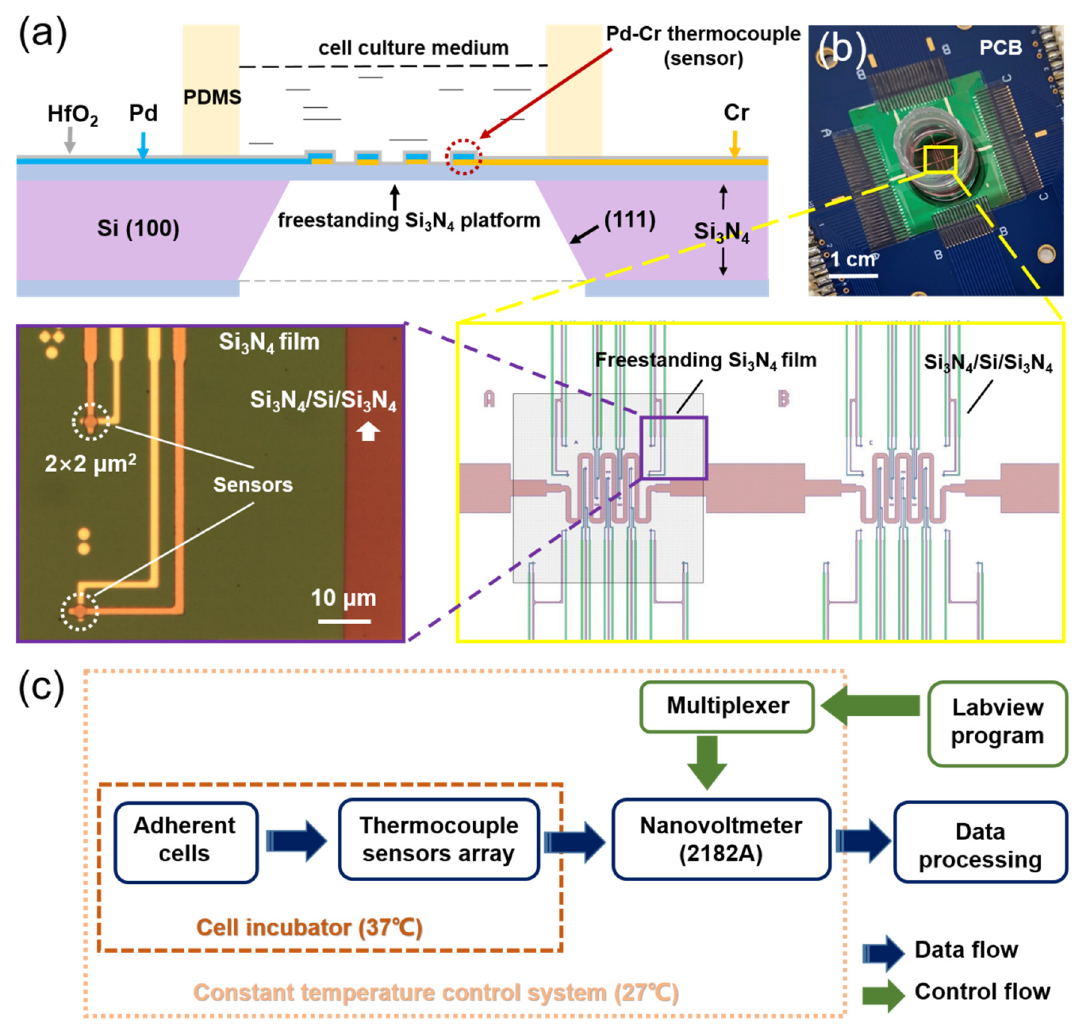
Figure 1. Schematic illustration of the new biochip and measurement system. ( a ) Schematic diagram of a cross-section of the functional area on the chip. The cream-colored bars labeled PDMS represent a cross-section of the polydimethylsiloxane ring that contains the cell-culture pool (see Experimental Section). ( b ) Optical photo of the whole chip, including the functional area. The chip is mounted on a printed-circuit board (PCB). ( c ) The working principle of the homemade, low-noise cell-temperature detection system.